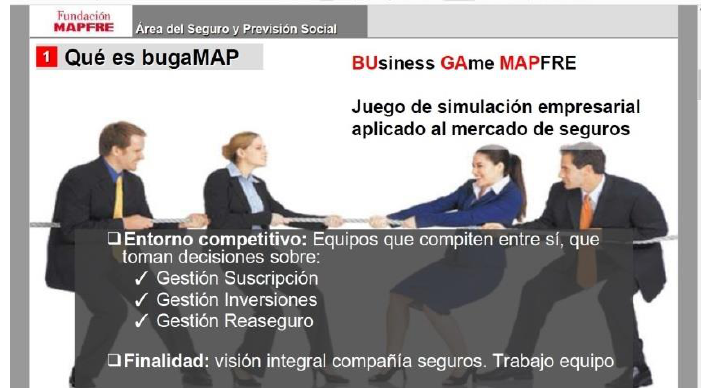
Figure 2. BugaMAP game is a team competition. Source: Fundación Mapfre [29].